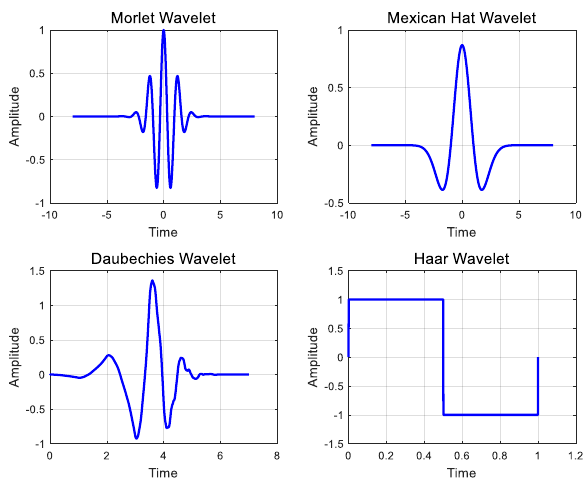
Figure 11. Example of mother wavelets.